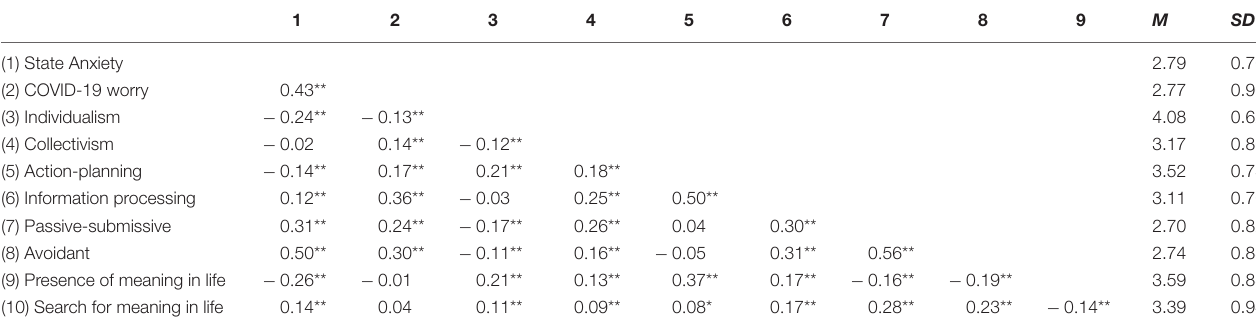
TABLE 2 | Correlations, means and standard deviations of main